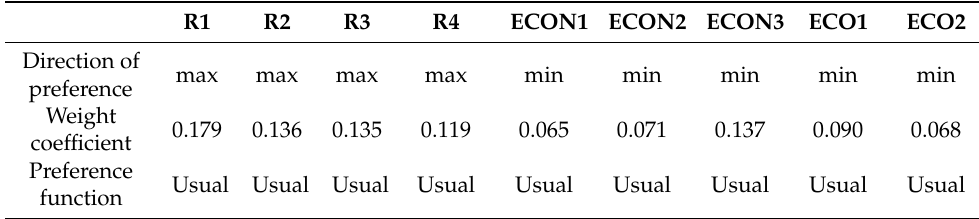
Table 2. The parameters of multi-criteria analysis for